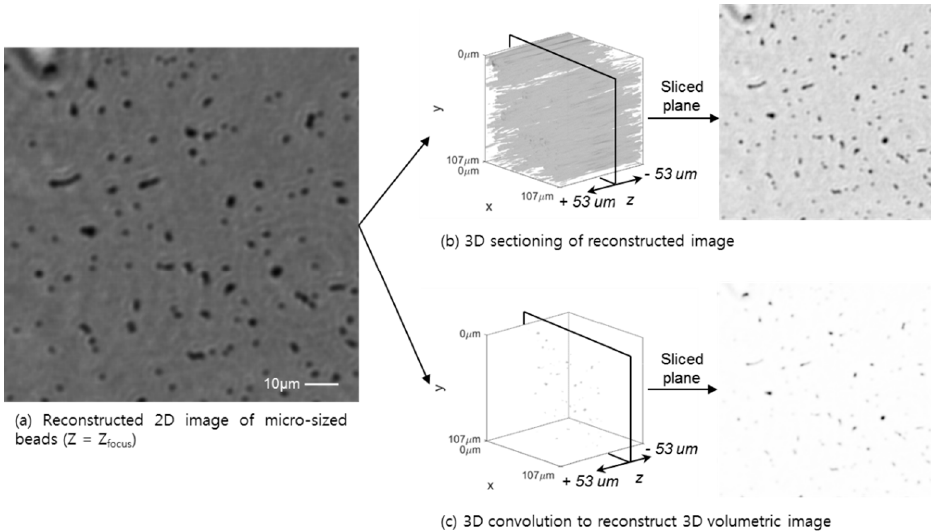
Figure 5. Planar and volumetric representation of the deconvolution results of the micro-sized beads sample (1 um diameter) are presented, both for the 2D reconstruction, i.e., slide sectioning, and 3D convolution, with a high resolution. ( a ) The planar image at the focused plane of the object (Z focus = 721 um). ( b ) The stack of each focused plane generates a 3D volume representation. The high-resolution 3D object image has a pixel-super-resolution that is six times higher, processed from 36 low-resolution images. The 2D and stacked 3D image shows background artifacts, which reduce the 2D and 3D image contrast. ( c ) Volumetric deconvolution result of the object. Intensity distribution along the Z-direction through the full thickness shows a clear 3D image with reduced artifacts and increased 3D image contrast.